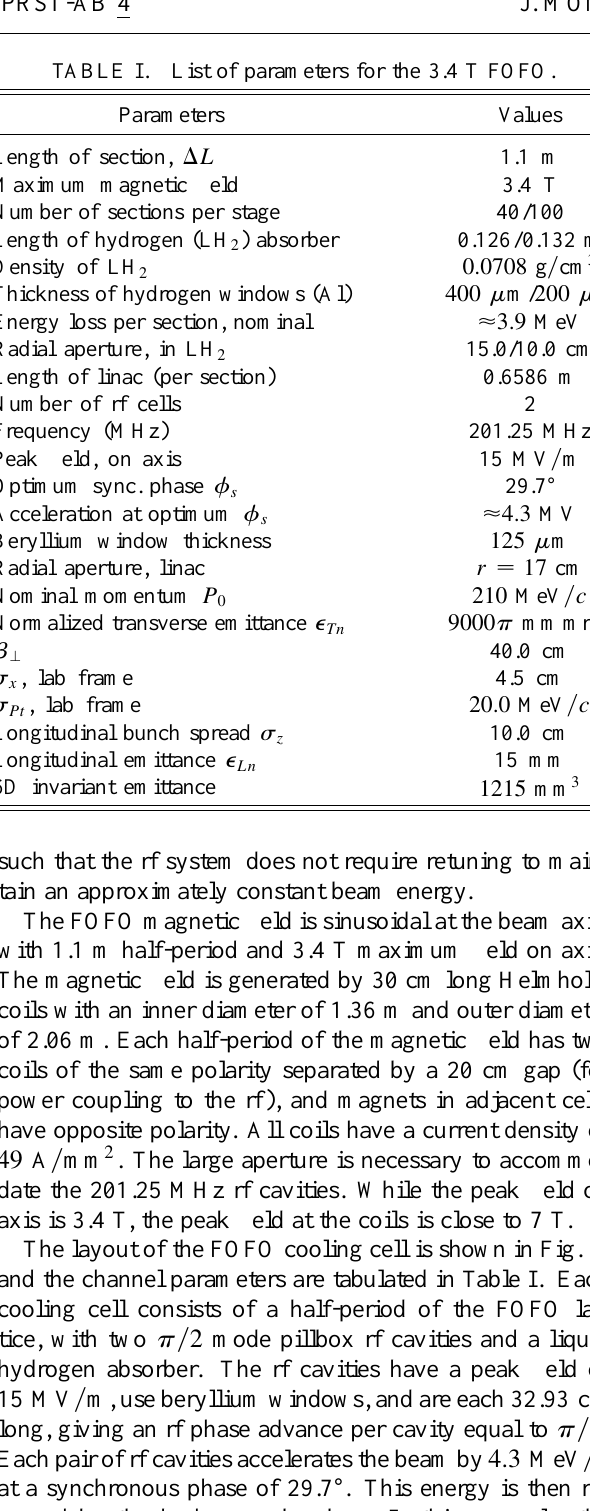
Table II. For comparison, a total energy of (cid:11) 600 MeV